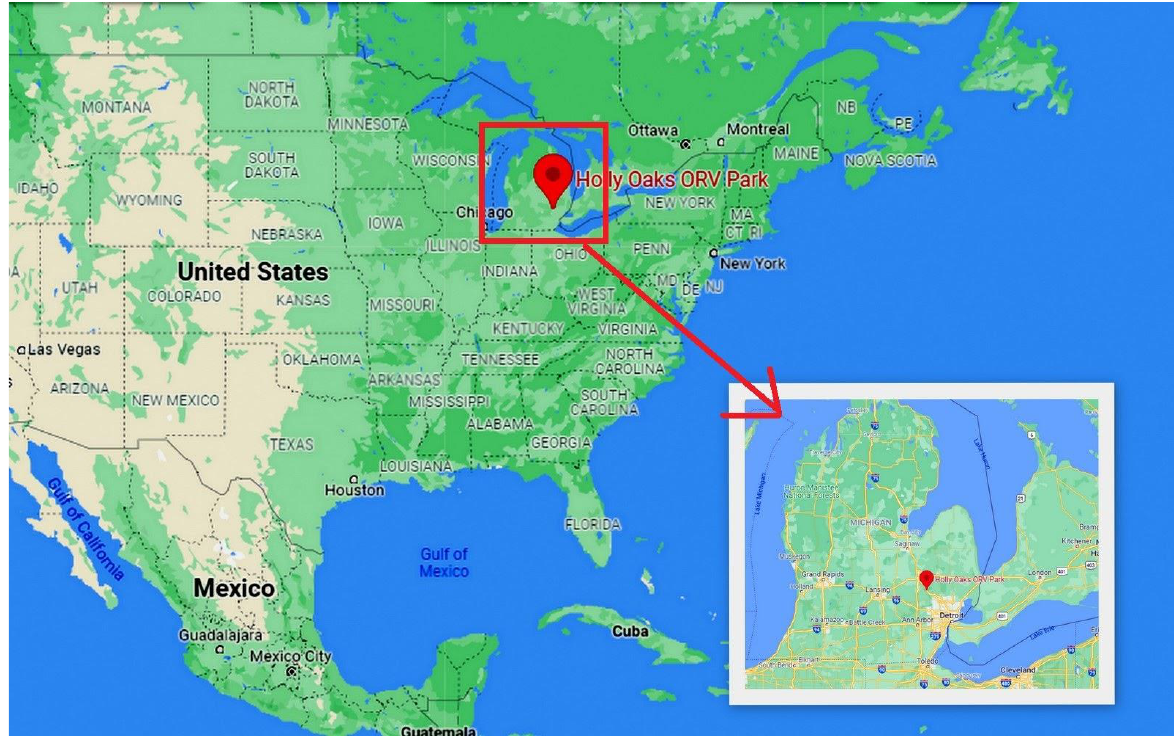
Figure 1. Location of the Holly Oaks off-road vehicle park — Michigan, USA.